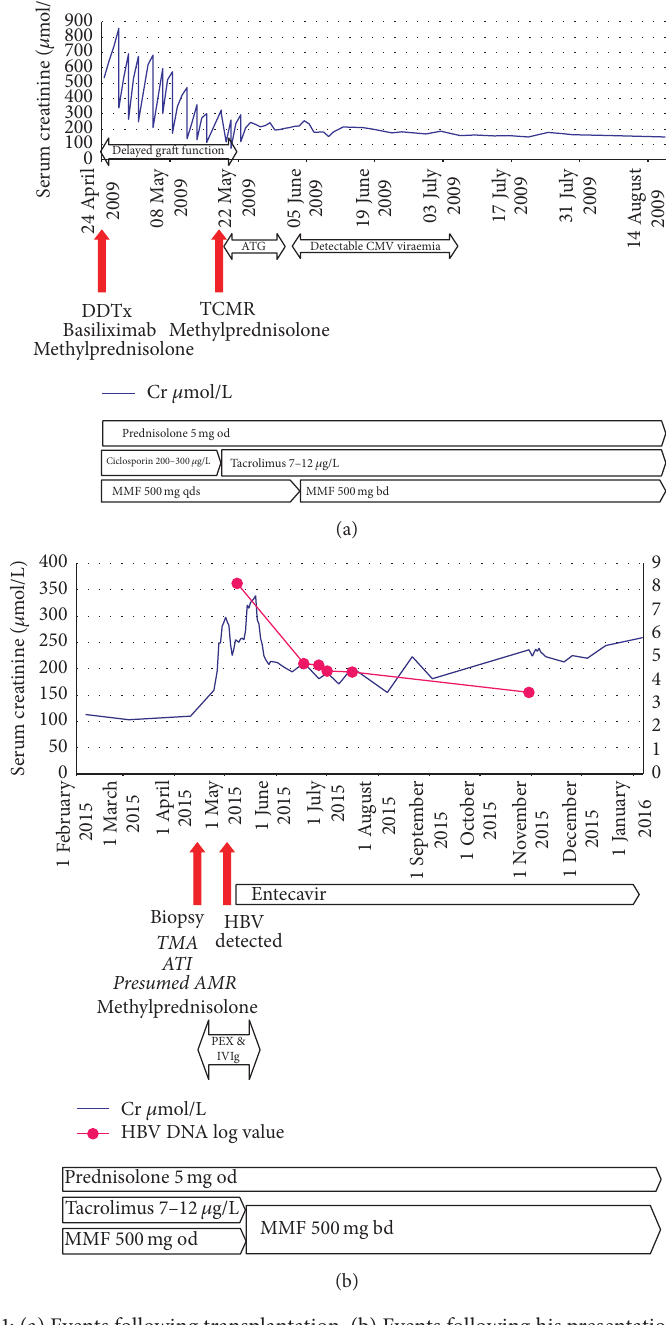
Anti-HBs levels should be checked annually and boosted as indicated [2, 6,